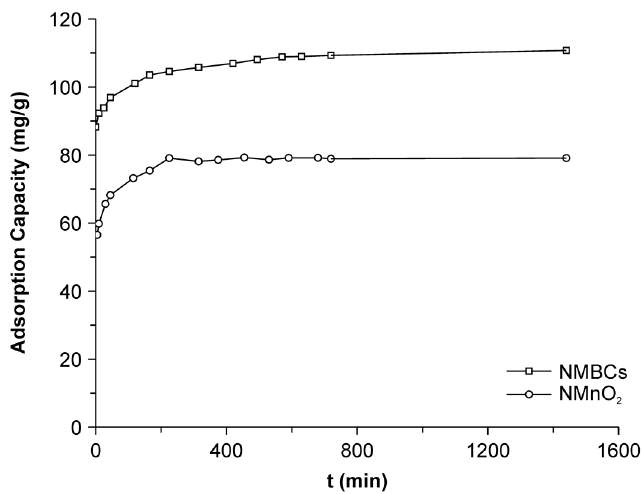
Figure 2. Adsorption kinetics of Cu(II) by NMBCs and NMnO 2 .